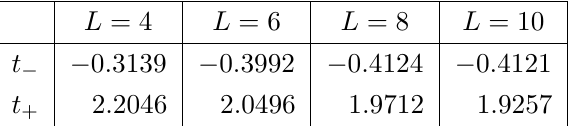
Table 4 . Approximate values of the tachyon coe(cid:14)cients t where Newton’s algorithm stops con- verging for branch A at levels ( L; 3 L ) in Schnabl